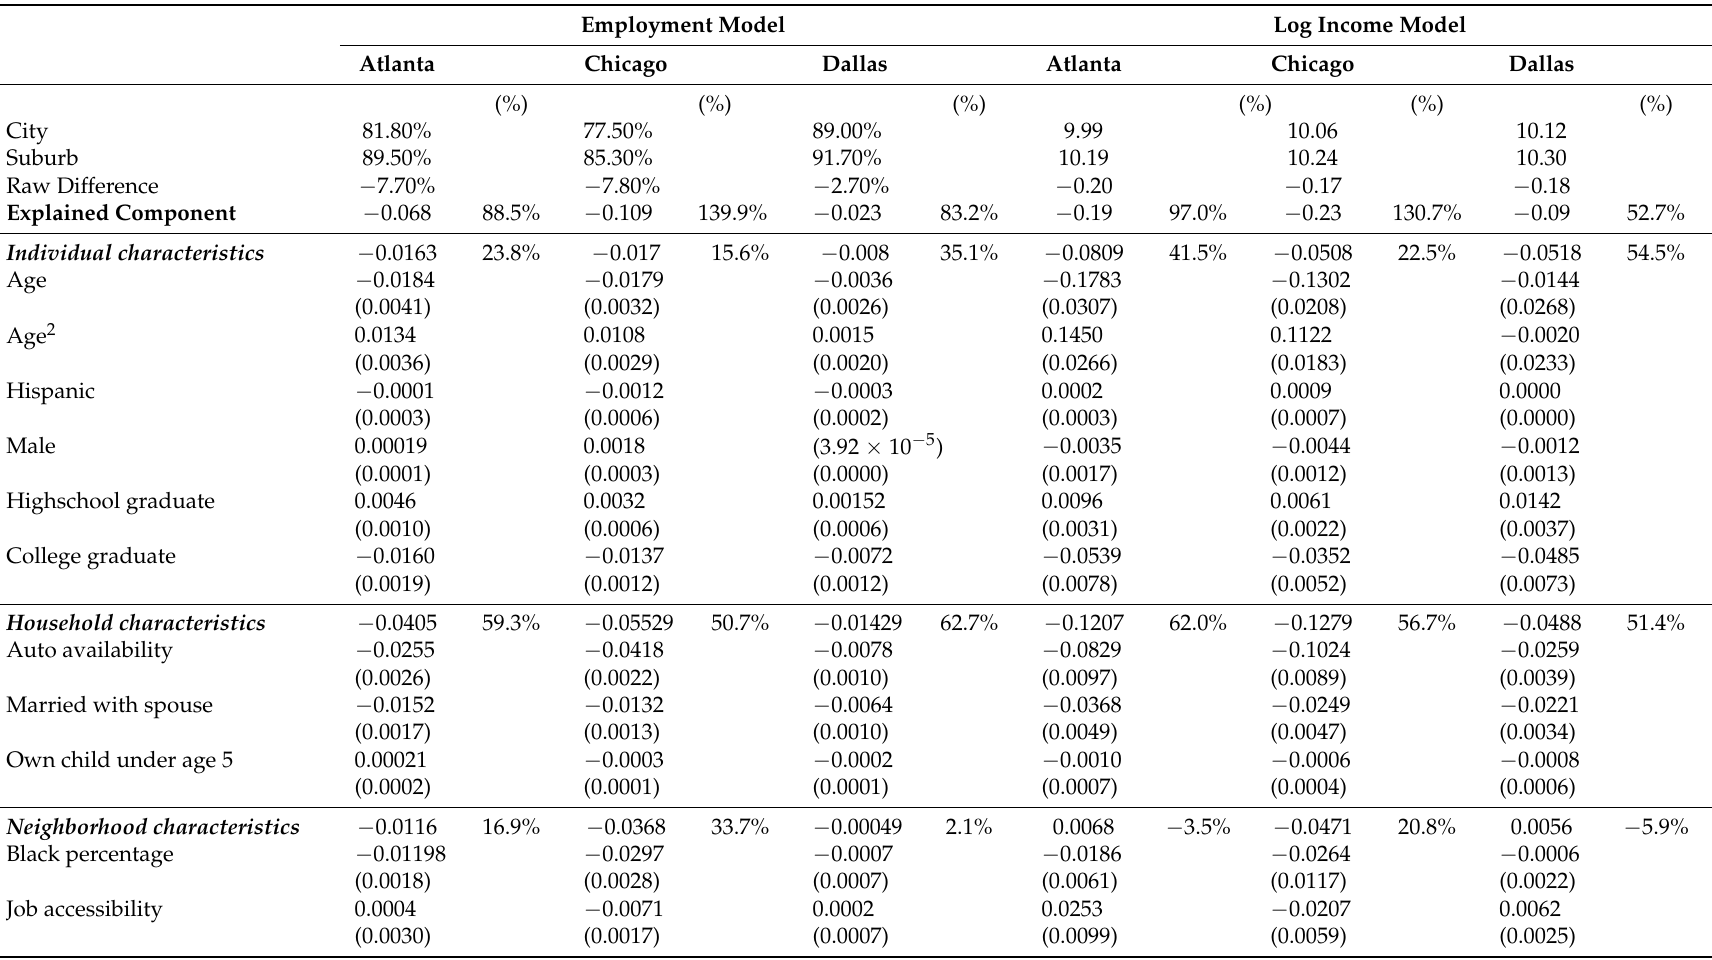
Table 4. Decomposition of the differences in employment and log income by the residence in the city and the